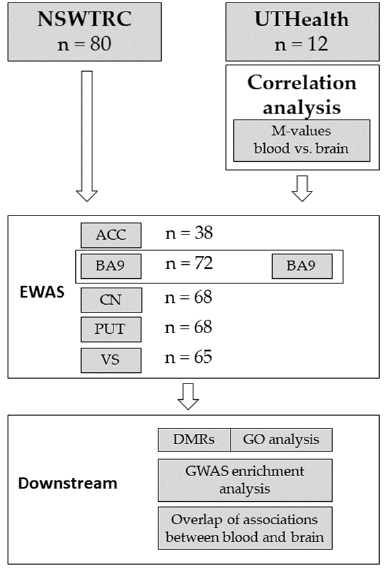
Figure 1. Analysis Figure 1. Analysis flowchart.